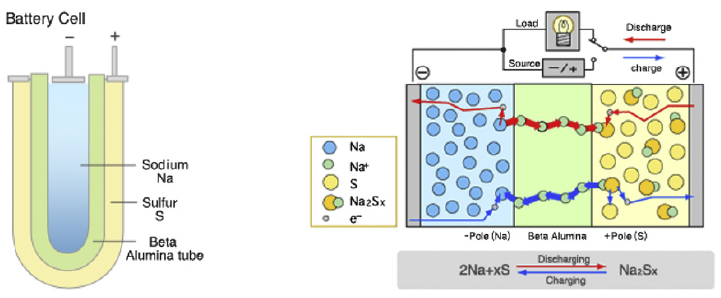
Figure 2. Diagram of NaS battery